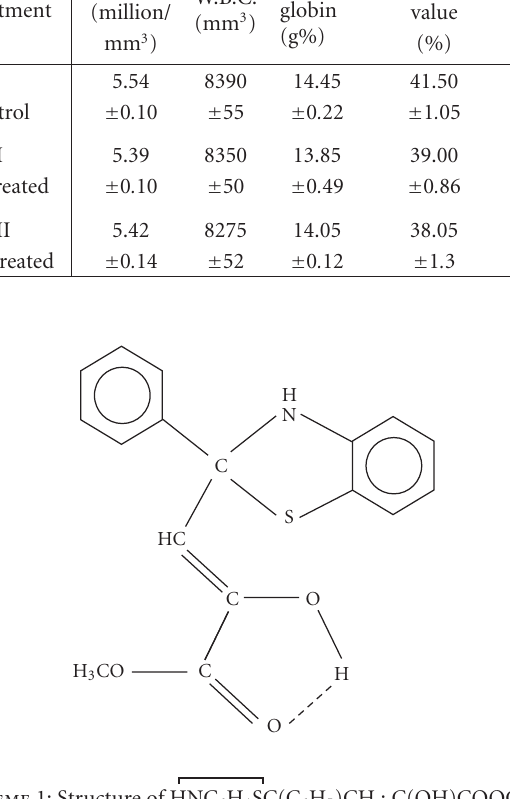
Table 2: E ff ects of compounds 1 and 2 on blood and serum profile (values are mean ± SEM ( n = 6)).